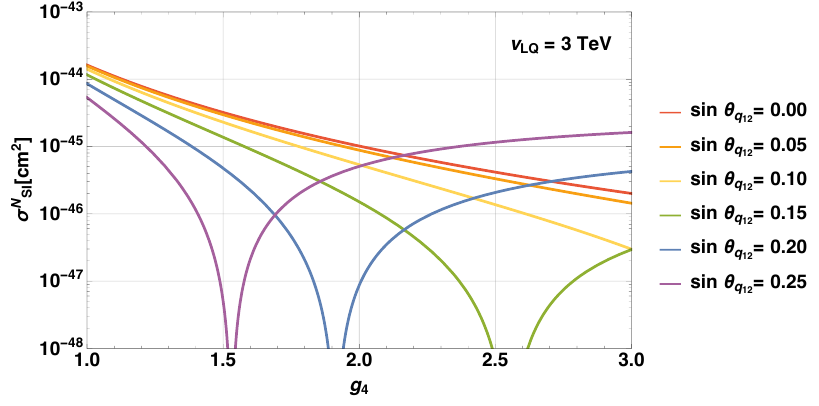
Figure 3 . The DM-nucleon cross-section (see eq. (4.3)) as a function of g 4 for di(cid:11)erent choices of the mixing angle sin (cid:18) q and v LQ = 3 TeV. See text for details. 12